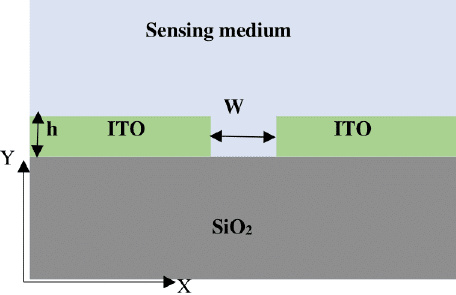
Figure 1. Cross-sectional view of an ITO-based plasmonic slot waveguide. The blue region, which consists of the slot region and upper cladding, is considered as the sensing